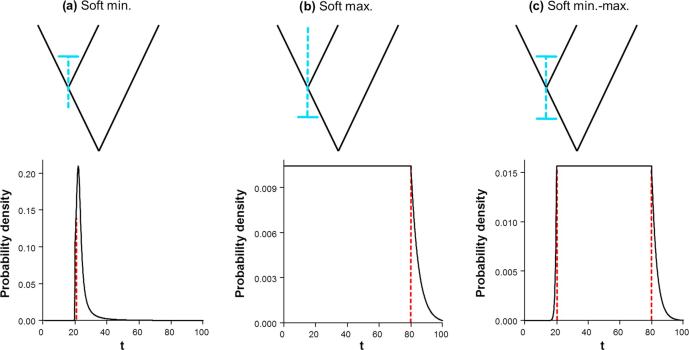
Probability densities for describing uncertainties in fossil calibrations: (a) soft minimum bound represented by a shifted-exponential distribution specified as tL = 20, p = 0.1, c = 0.1, pL = 0.01; (b) soft maximum bound specified as “tU = 80, pR = 0.05”; and (c) soft lower and upper bound, specified as “tL = 20, tU = 80, pL = 0.01, pU = 0.05”. Black solid lines represent calibration densities. Red dashed lines represent (a) minimum age (tL,), (b) maximum age (tU) and (c) both (tL, tU). (For interpretation of the references to colour in this figure legend, the reader is referred to the web version of this article.)